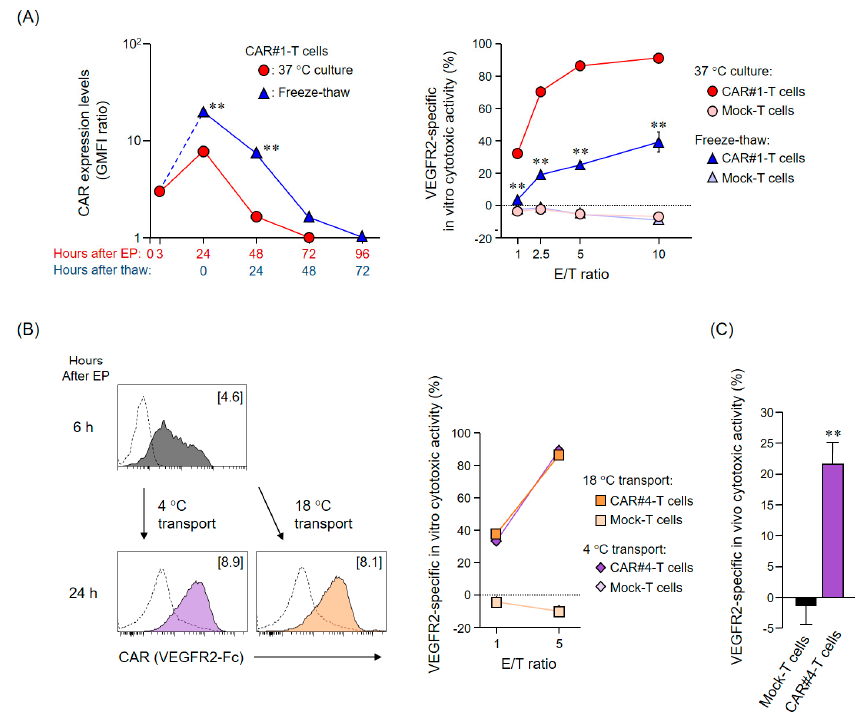
Figure 2. E ff ects of cryopreservation and cold or room temperature conditions on CAR-mRNA- transfected T cells. ( A ) E ff ect of cryopreservation on mRNA-transfected CAR-T cells. CAR#1-T cells were cultured for 3 h after EP and then slowly frozen using a frost protection reagent (CP-1). Twenty-one hours later, they were thawed rapidly (24 h after EP). Then, CAR expression (left panel) and VEGFR2-specific in vitro cytotoxic activity (right panel) were evaluated in freeze-thawed CAR-T cells and compared to those of continuously cultured CAR-T cells at 37 ◦ C for 24 h after EP. CAR expression was analyzed using flow cytometry using an anti-HA-tag antibody or the respective isotype control antibody. The VEGFR2-specific in vitro cytotoxic activity of CAR-T cells was evaluated via co-culture with L1.2 cells and VEGFR2 + L1.2 cells at the indicated E / T ratios. The data are shown as the mean ± SD of triplicates and are representative of at least two independent experiments using the same donor-derived T cells. Statistical analysis was performed using the Student’s t -test: ** p < 0.01, freeze-thawed CAR#1-T cells versus 37 ◦ C cultured CAR#1-T cells. ( B ) E ff ect of di ff erent temperature conditions on mRNA-transfected CAR-T cells. Human T cells transfected with CAR#4-coding mRNA via EP were cultured for 18 h and then subjected to cold (4 ◦ C) or room temperature (18 ◦ C) conditions for 6 h. Then, CAR expression (left panel) and VEGFR2-specific in vitro cytotoxic activity (right panel) were evaluated. CAR expression was analyzed using flow cytometry using VEGFR2-Fc chimera / anti-human IgG antibody (solid color histograms) or anti-human IgG antibody only (dashed white histograms). The VEGFR2-specific in vitro cytotoxic activity was evaluated via co-culture with L1.2 cells and VEGFR2 + L1.2 cells at the indicated E / T ratios. The data are shown as the mean ± SD of triplicates and are representative of at least two independent experiments using di ff erent donor-derived T cells. ( C ) Analysis of in vivo cytotoxic activity of mRNA-transfected CAR-T cells preserved under 4 ◦ C conditions. NOG mice received fluorescently labeled L1.2 and VEGFR2 + L1.2 cells via retro-orbital vein injection. Two days later, mice received CAR#4-T cells or mock-T cells preserved at 4 ◦ C via the same route. Then, two days later (four days after L1.2 and VEGFR2 + L1.2 cells administration), the number of L1.2 cells and VEGFR2 + L1.2 cells in the spleen of these mice was evaluated using flow cytometry. The VEGFR2-specific in vivo cytotoxic activity was given using the ratio of VEGFR2 + L1.2 to L1.2 cells. The data are shown as the mean ± standard error of the mean of the results obtained for the 4 and 6 mice treated with mock-T and CAR#4-T cells, respectively. Statistical analysis was performed using the Welch’s t-test: ** p <